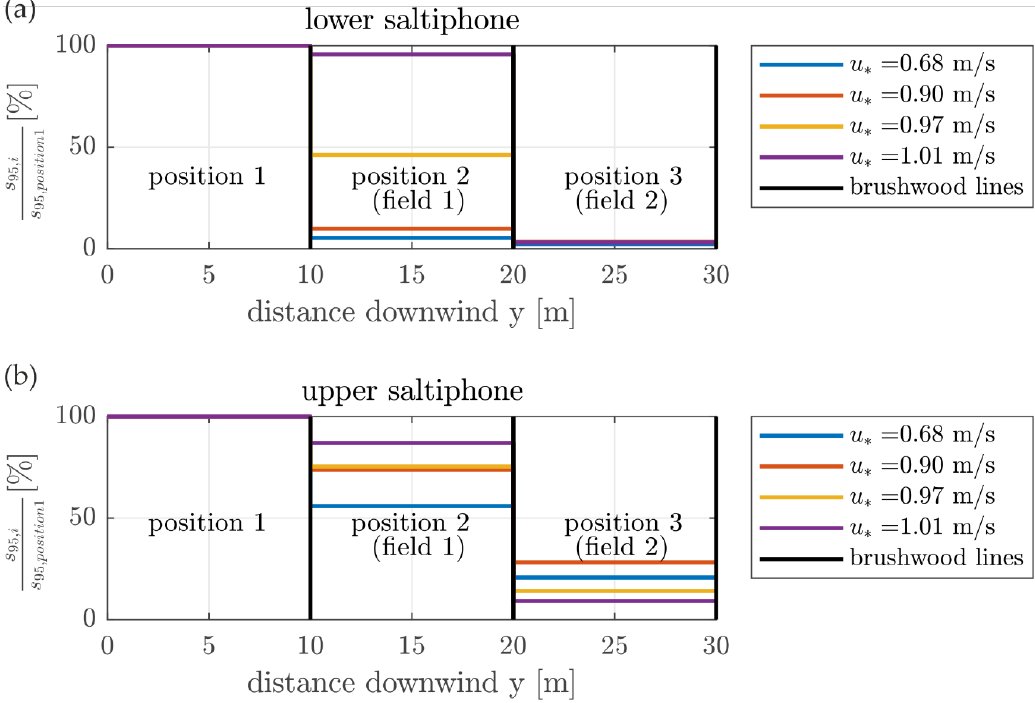
Figure 15. Comparison of the downwind evolution of the saltiphone data before and behind the sand trapping fence for different shear velocities for ( a ) the lower saltiphone and ( b ) the upper saltiphone. For all shear velocities between u* = 0.68 – 1.01 m/s, the counted saltation impacts were significantly reduced between the sand trapping fences, indicating the deposition of sand in the distance downwind. In field 1 (position 2), the sediment transport for the lower saltiphone was reduced between 5–95% compared to position 1, and, in field 2 (position 3), the sediment transport was reduced between 96–98% compared to position 1. For the upper saltiphone, the sediment transport in field 1 (position 2) was reduced between 13–44% compared to position 1, and, in field 2 (position 3), the sediment transport was reduced between 72–91% compared to position 1. At high shear velocities of up to u* = 1.01 m/s, the sand transport in field 1 was only slightly reduced for both saltiphone heights. For the upper saltiphone, the saltation impact was less reduced compared to the lower saltiphone. Due to the installation of the bundled brushwood, the sand trapping fence was relatively dense directly above the bed surface. This indicates that more sediment grains hit the brushwood and were deposited close to the bed surface.